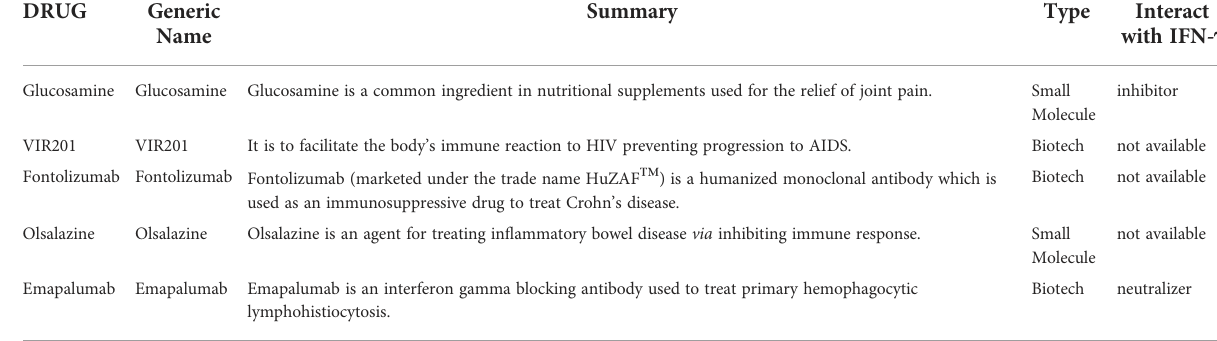
TABLE 1 Potential Drugs targeting IFN- g derived from the DrugBank